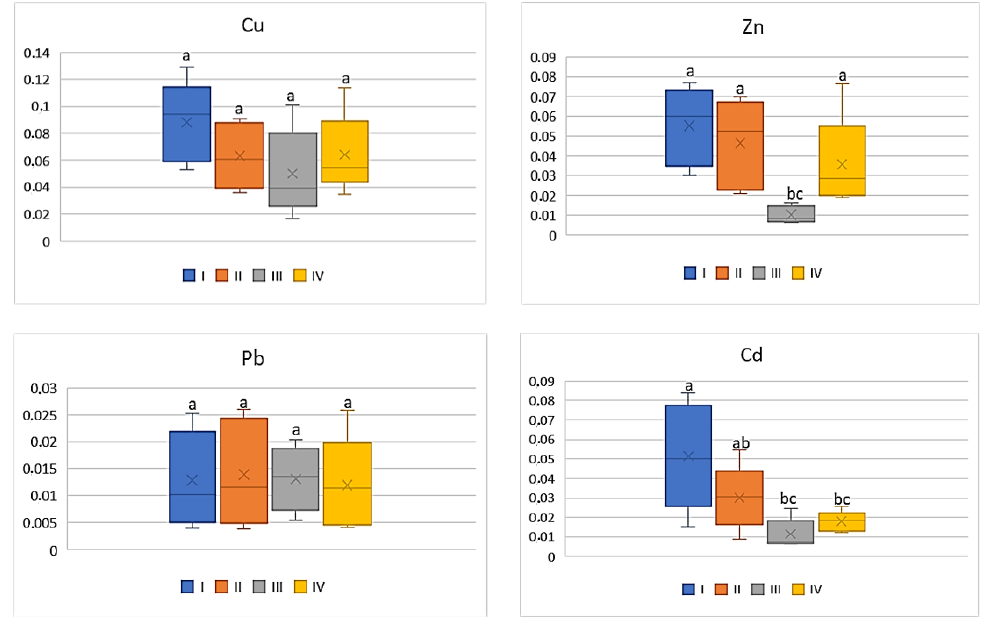
Figure 3. BCF values for tomato depending on the metal and study zones. The same letters mean no significant differences between the values.